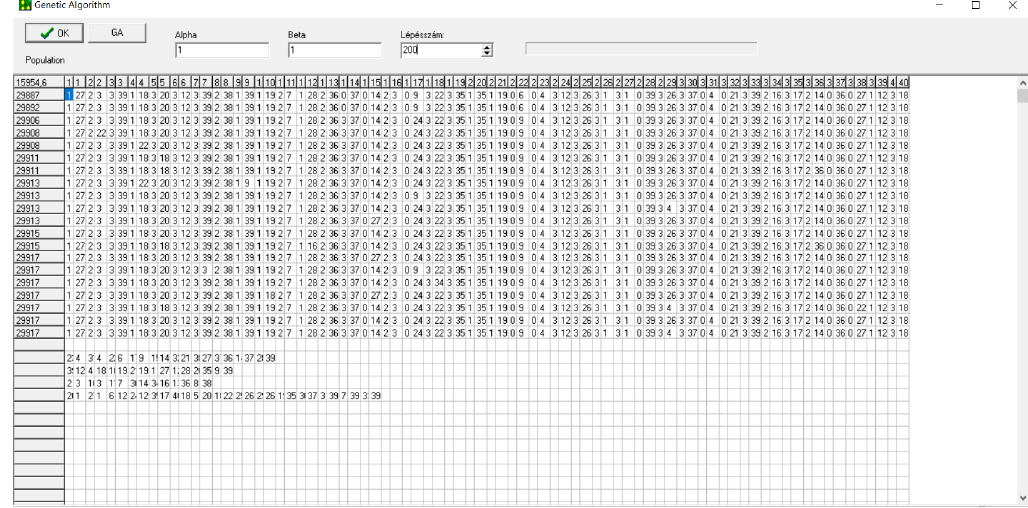
Figure 3. The optimization panel with the